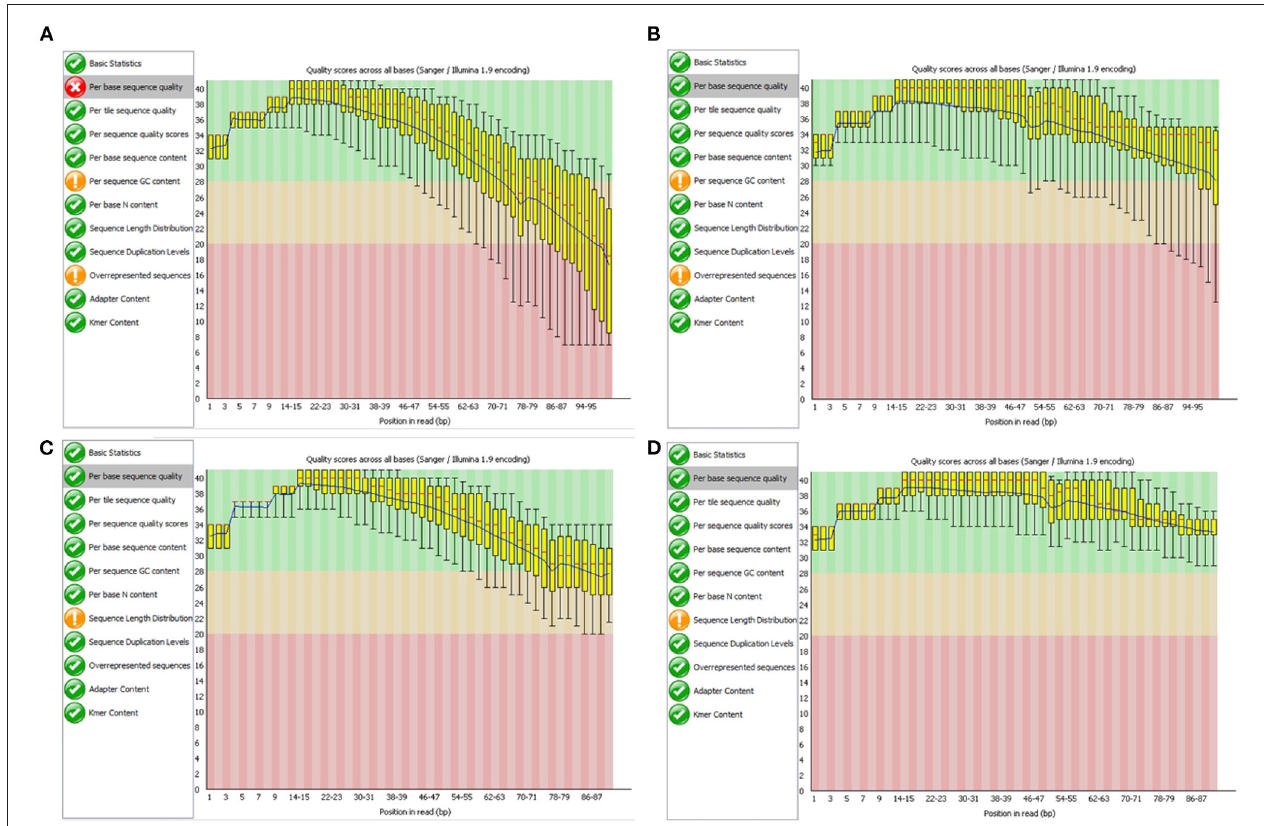
FIGURE 8 | Evaluation of nucleotide sequence quality in the FASTQ files SRR999074_1 (A,C) and SRR999074_2 (B,D) before (A,B) and after (C,D) improving the quality with the developed